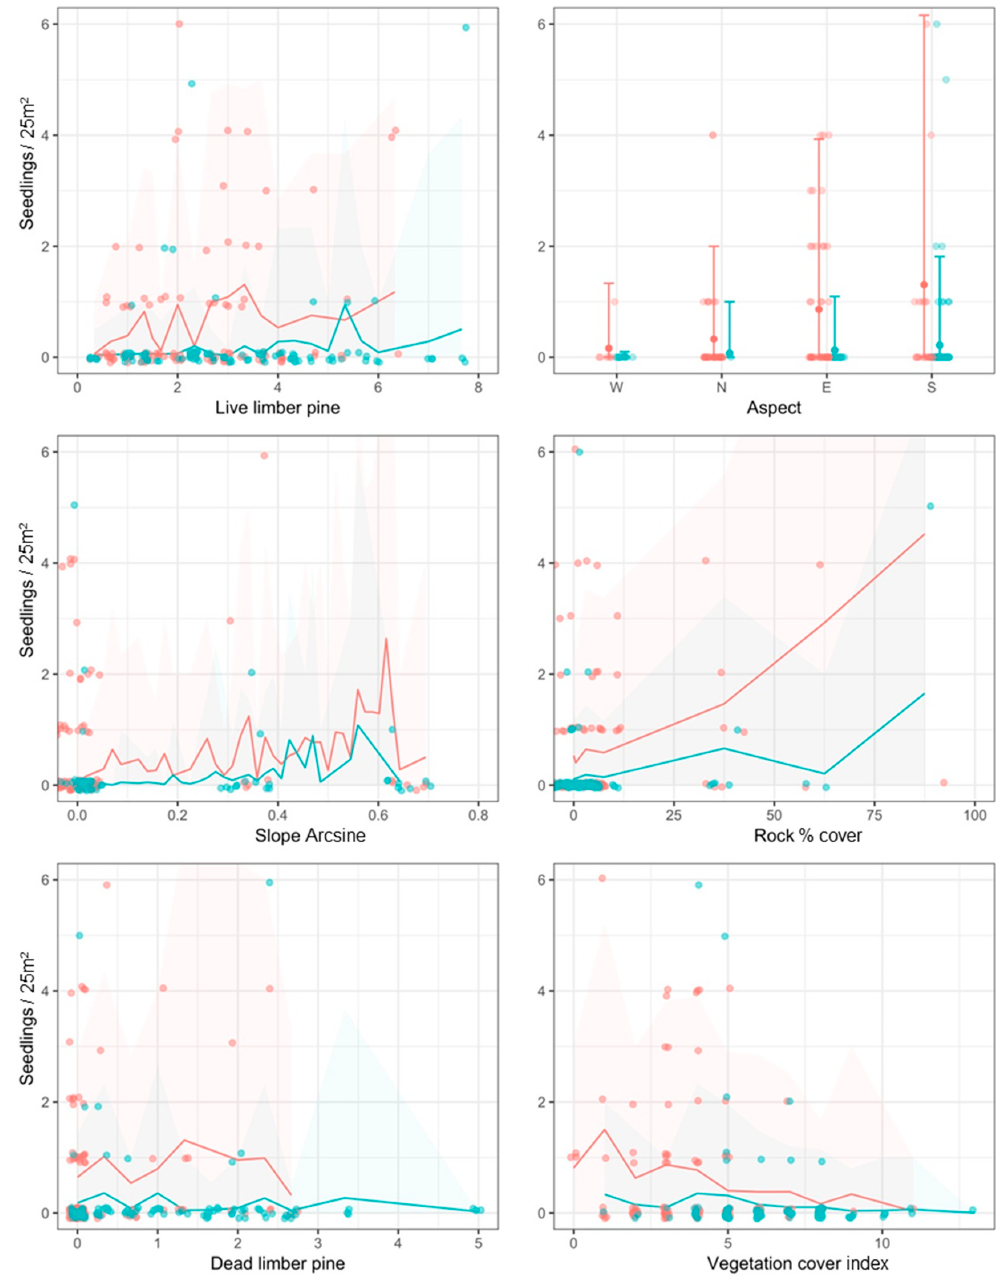
Figure 2. Distribution of seedling counts in northern (red) and southern (blue) ecosystems relative to: ( a ) seed availability (basal area (BA) live limber pine, m 2 /ha), microsite, as given by ( b ) aspect (average cardinal direction), and ( c ) slope, ( d ) substrate (rock cover), ( e ) disease (BA of dead limber pine, m 2 /ha), and ( f ) competition (vegetation cover index); variables a–d were included in the count portion of the final zero inflated Poisson model, while e–f were included in the zero inflated component of the model. Data points are slightly transparent and jittered to aid visualization. The lines represent the final model predictions conditioned on both the zero inflated and random effect components of the model and held at their average, while testing the effect of individual variables named in plots ( a – f ). Shaded regions represent the 95% CI of the model predictions.